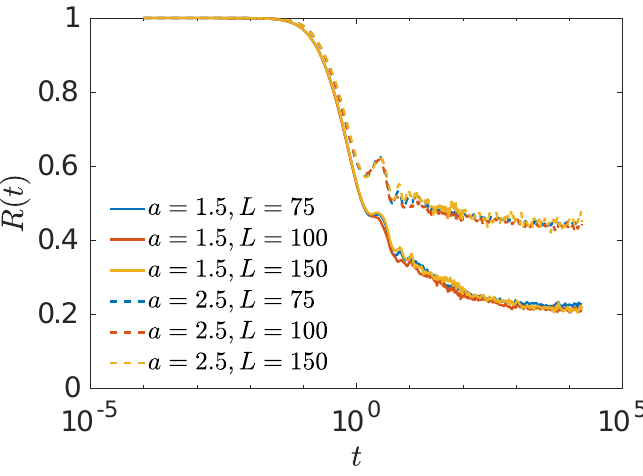
Figure 8: Survival probability of the delta-peak initialized wave packet in the localized phase for the disorder strength W = 20, β = 0.3, and a = 1.5 (solid lines), a = 2.5 (dashed lines) for different system sizes L = 75, 100, and 150 with the corresponding number of disorder realizations 1000, 750, and 400,